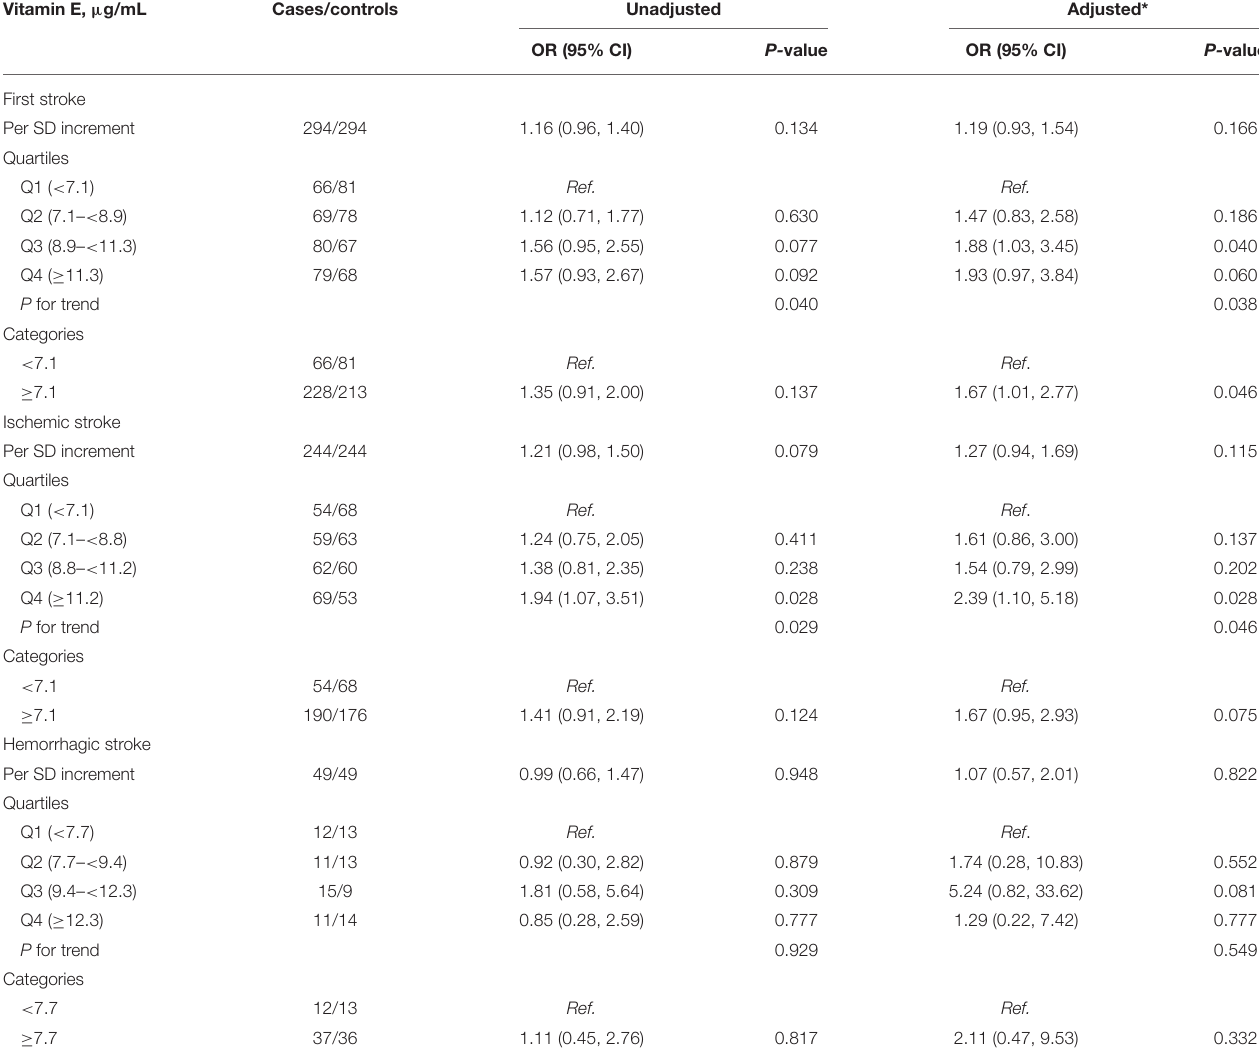
TABLE 2 | Relationship of plasma vitamin E with the risk of first stroke in males. Vitamin E, µ g/mL